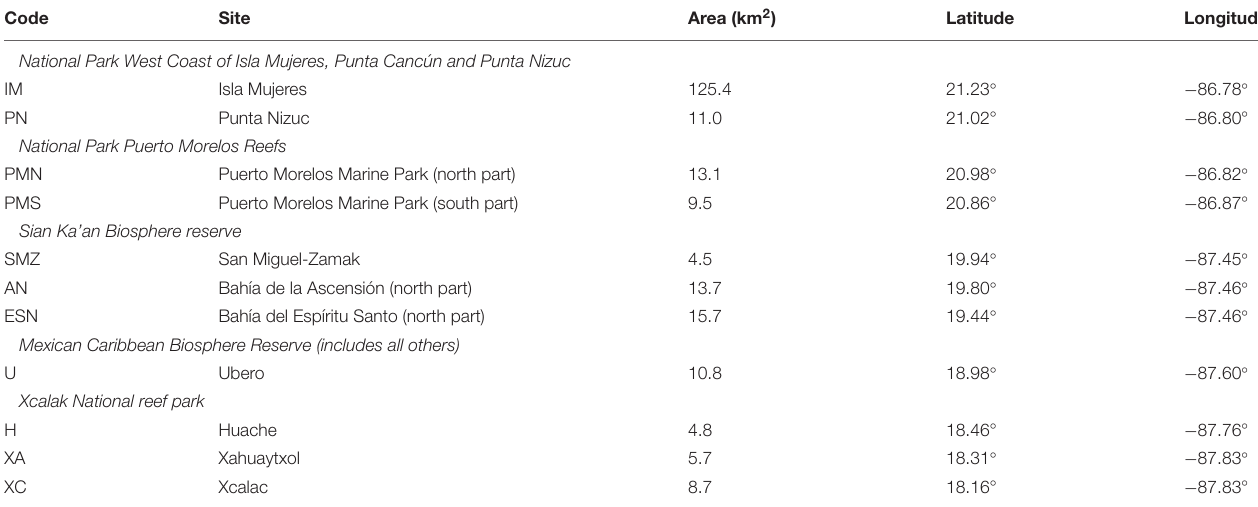
TABLE 1 | The eleven sites of interest referred to in the results, listed north to south and indicating the marine parks or reserves they are contained